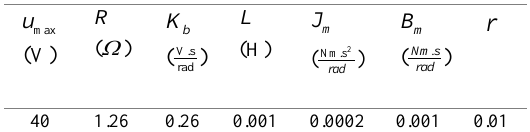
Table 1. Specifications of DC